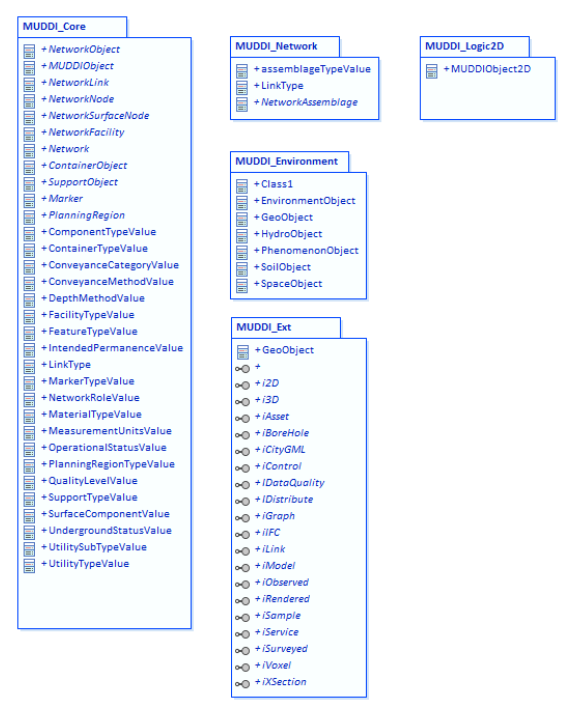
Figure 1. MUDDI UML specification packages